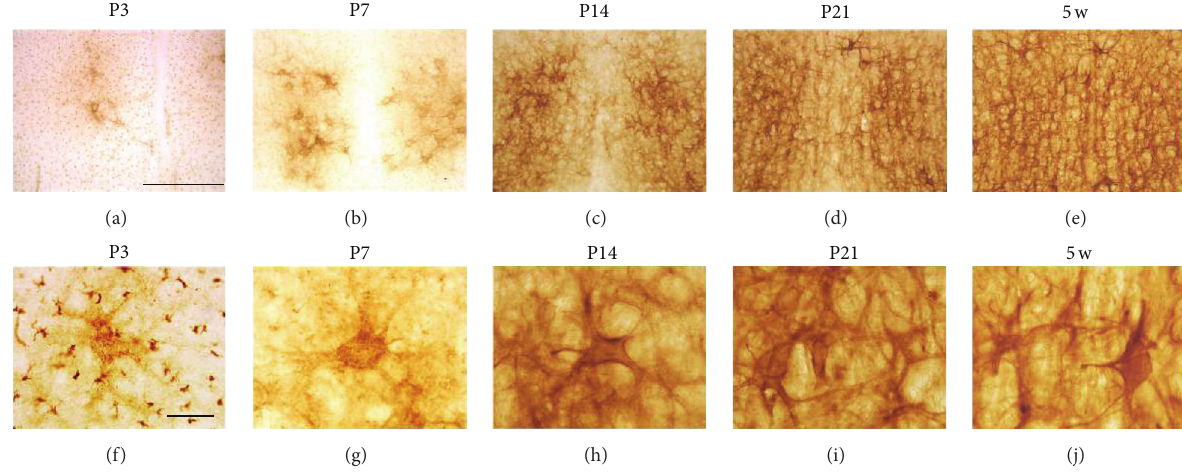
Figure 5: WFA-stained ECM in the Gi of the pons. (a–j) Low- (a–e) and high- (f–j) power images of WFA labeling in the Gi at P3 (a, f), P7 (b, g), P14 (c, h), P21 (d, i), and 5 w (e, j). PNN-like staining was observed at P3 and P7, which became clearer and more complicated from P14 onward. Gi: gigantocellular nucleus. Scale bars = 500 (a–e) and 50 (f–j) 𝜇 m.